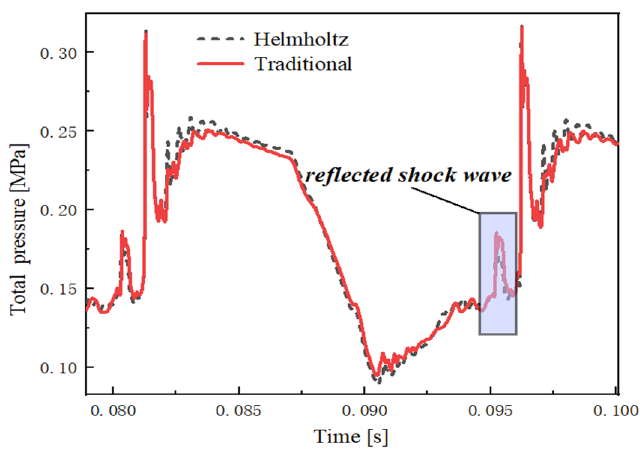
Figure 9. The curve of the shock wave intensity in the two gas wave tubes at the front end of the chamber versus time.